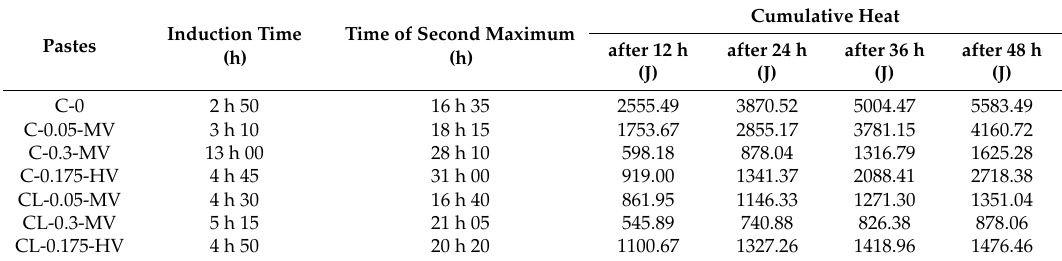
Table 5. Characteristic parameters of heat evolution curves for all pastes (Figures 3 and